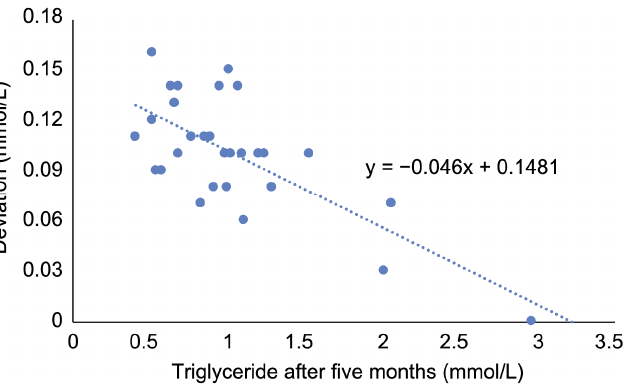
Figure A1. Deviation in triglyceride levels plotted against the triglyceride levels when analyzed after being stored at − 20 °C for five months ( n = 30).